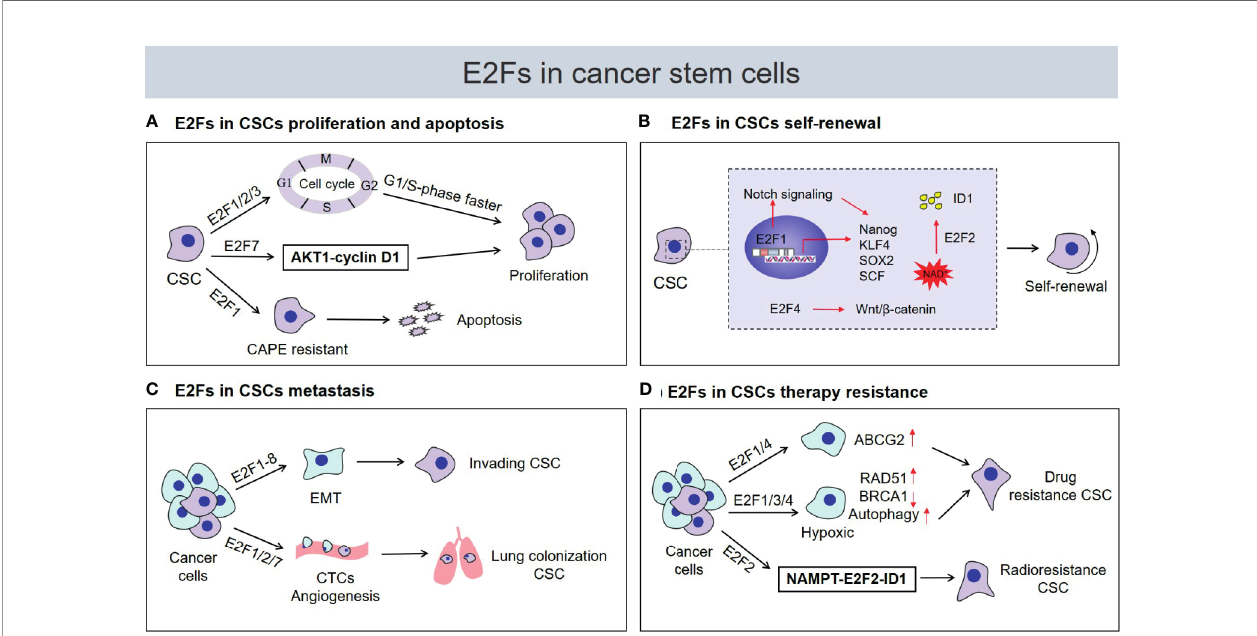
FIGURE 2 | Roles of E2Fs in cancer stem cell (CSC) biological characteristics. Tumor cells are heterogeneous, including immortal cancer stem cells. CSCs usually express high levels of E2F transcription factors and are characterized by (A) enhanced proliferation or induction of apoptosis, (B) acquisition and maintenance of self ‐ renewal capability, (C) enhanced invasion and metastasis potential, (D) regulation of drug or radiation resistance. CAPE, caffeic acid phenethyl ester; ID1, inhibitor of differentiation 1; NAD + , nicotinamide adenine dinucleotide; CTCs, circulating tumor cells; NAMPT, nicotinamide phosphoribosyl